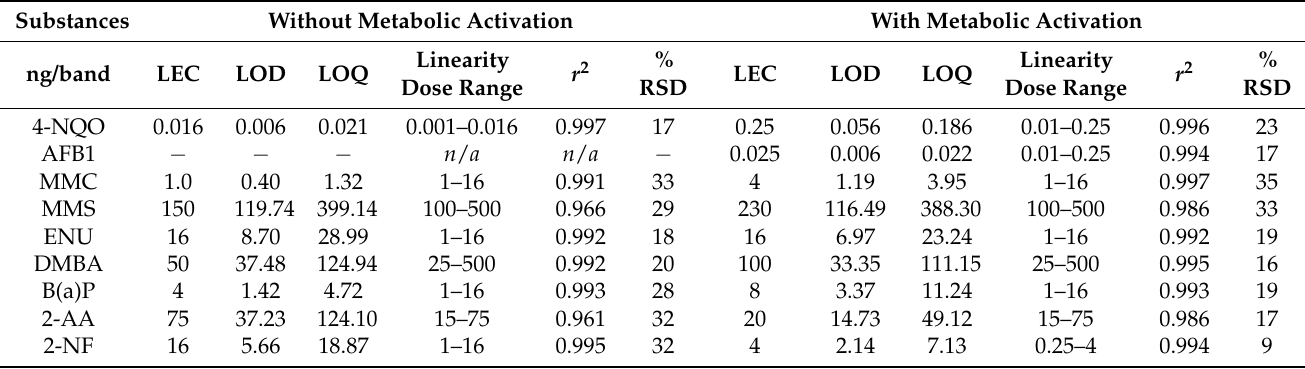
Figure 6. Dose–response study for MMS (100–760 ng/band) ( A ) in absence ( − S9) and ( B ) in presence (+S9) of metabolic activation. Bioautograms at FLD 254 nm (region of interest shown), biodensitograms at 485/>500 nm and ( C ) dose–responses curves with LEC (black dotted line at IR 2.0).